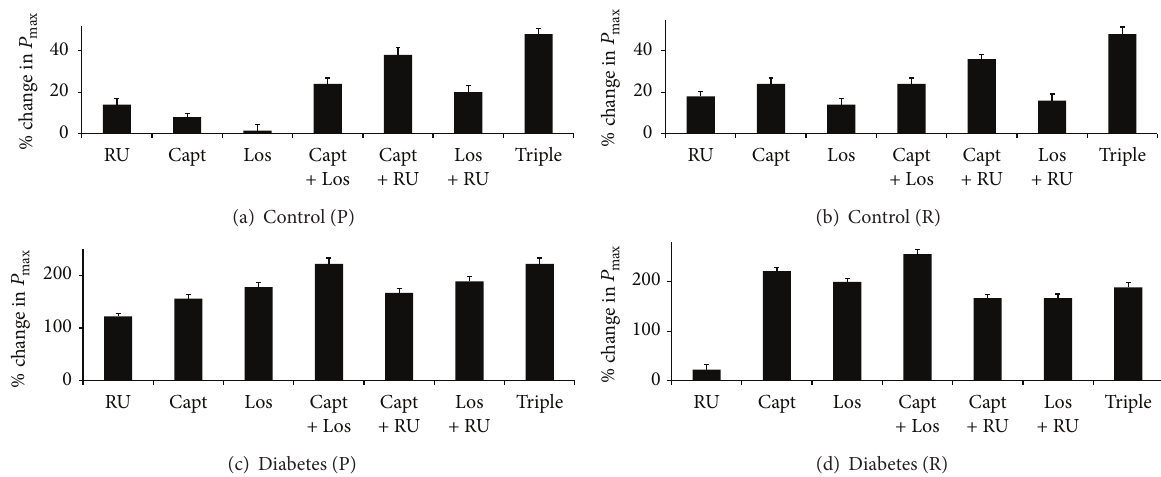
Figure 5: A comparison of the % change in left ventricular developed pressure ( 𝑃 max ) in control and diabetic hearts following acute treatment with various drug regimens. Drugs were given to control hearts during perfusion (a) or reperfusion (b) and to diabetic hearts during perfusion (c) or reperfusion (d). The percent change in parameter is calculated relative to the % recovery seen in the respective nondiabetic or diabetic controls. RU = RU28318; Capt: Captopril; Los: Losartan; Triple: RU28318 + Captopril + Losartan.